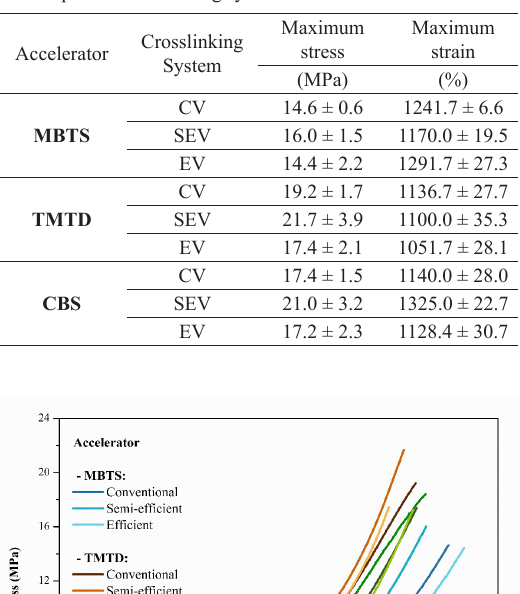
Table 3. Data obtained from the stress versus strain tests of vulcanized and accelerated NR compounds by: MBTS, TMTD and CBS in their respective crosslinking